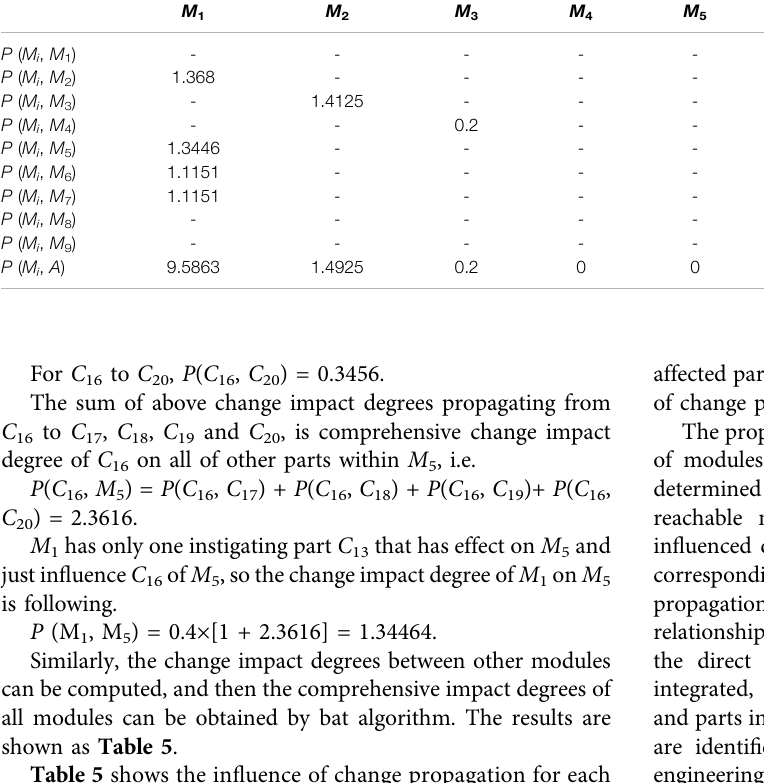
TABLE 5 | The results of change impact degrees of modules. M